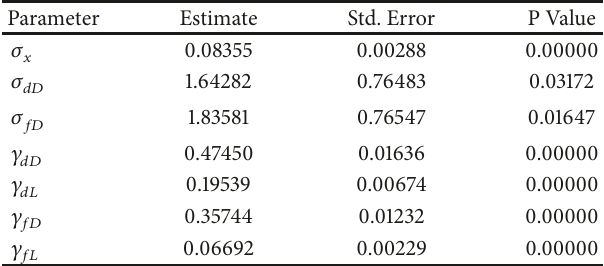
Table 5: Descriptive Statistics of the Simulated Overnight